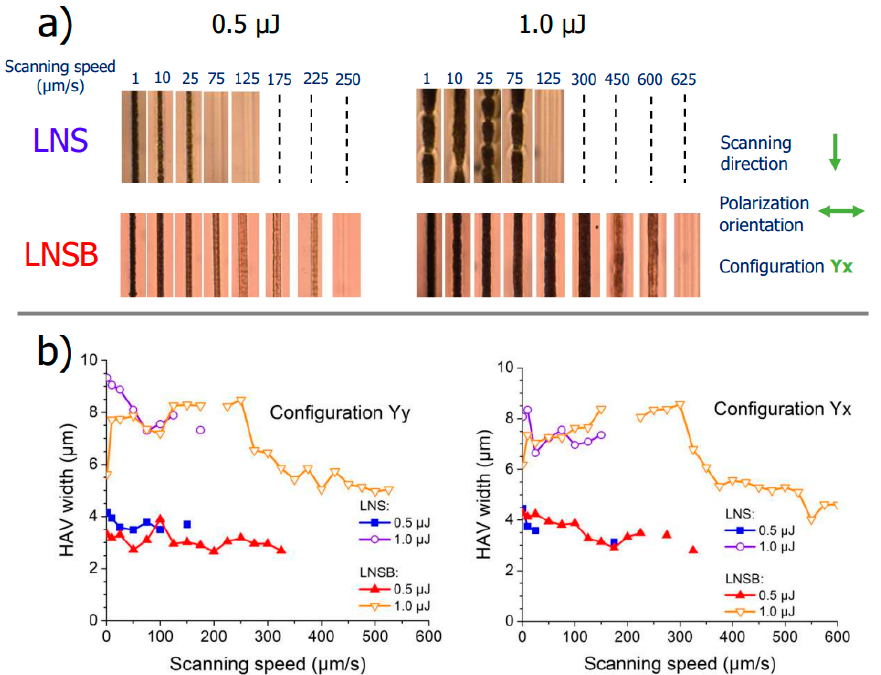
Figure 4. ( a ) Optical microscope images of lines inscribed by fs-laser in silicate (LNS) and borosilicate (LNSB) glasses at various scanning speeds and for two pulse energies: 0.5 and 1.0 µJ (Yx configuration). ( b ) Heat-affected volume (HAV) width as a function of scanning speed, measured from optical microscope images in LNS and LNSB glass samples, for 0.5 and 1.0 µJ, and in both Yy and Yx configuration modes. Other (fixed) parameters are: λ = 1030 nm; f = 200 kHz; NA = 0.6; pulse duration = 250 fs; focal depth: 240 µm (in air).